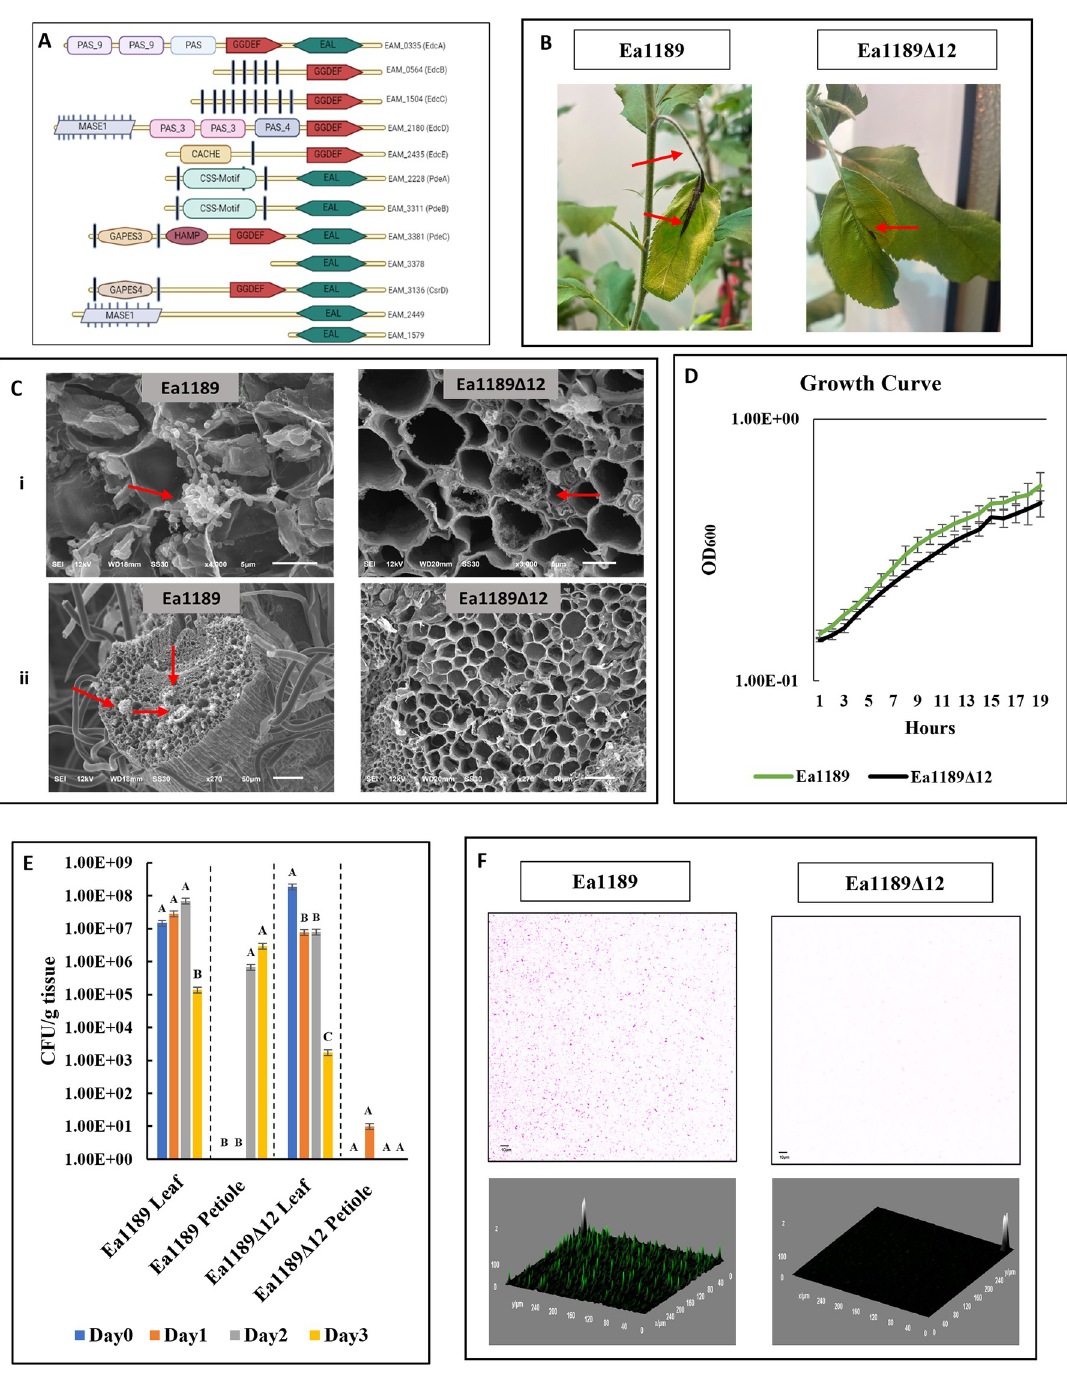
Fig 1. C-di-GMP is essential for host colonization. A) A representative protein domain architectural overview of all identified proteins in E . amylovora Ea1189 that contain a GGDEF and/or EAL domain. Filled black vertical bars represent transmembrane helices on the N-terminal domain. The image was created using Biorender. B) Images depicting disease progression in apple shoots infected with Ea189 and Ea1189 Δ 12 at 3dpi. While Ea1189 infected shoots show signs of infection the leaf and the petiole (red arrows), shoots infected with Ea1189 Δ 12 show minor signs of necrosis limited to the apoplast region in the leaf (red arrow) C) Scanning electron micrographs depicting sectional images of the i) apoplast and ii) xylem tissue of young apple shoot tips 3 dpi with E . amylovora Ea1189 and Ea1189 Δ 12. Widespread colonization was observed when shoot tips were inoculated with WT Ea1189 in both the apoplast and the xylem. However, shoots inoculated with Ea1189 Δ 12 showed less severe bacterial colonization in the apoplast and no evidence of any biofilm development within the xylem tissue in the petiole. D) Growth patterns in vitro for Ea1189 and Ea1189 Δ 12 don’t show any